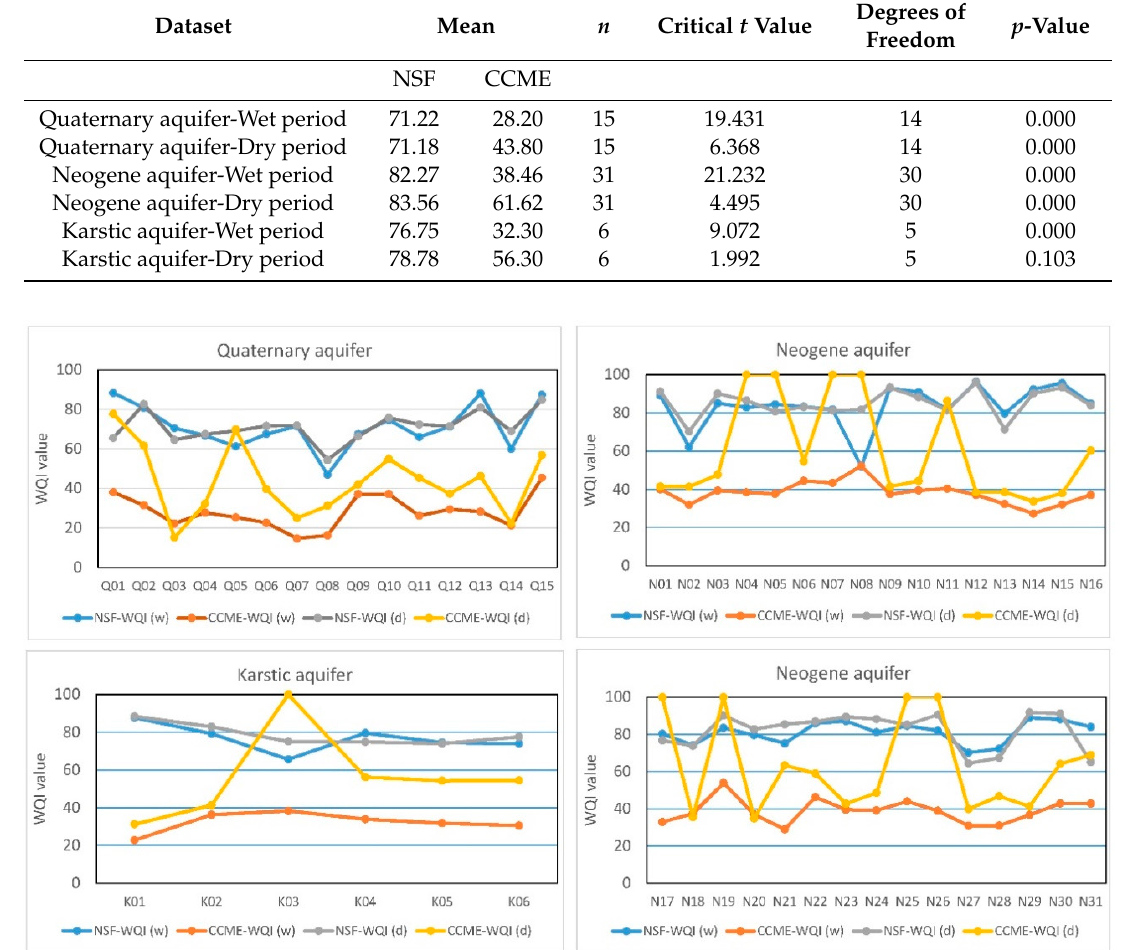
Figure 3. Variation of WQI values in the groundwater monitoring stations of the study area.